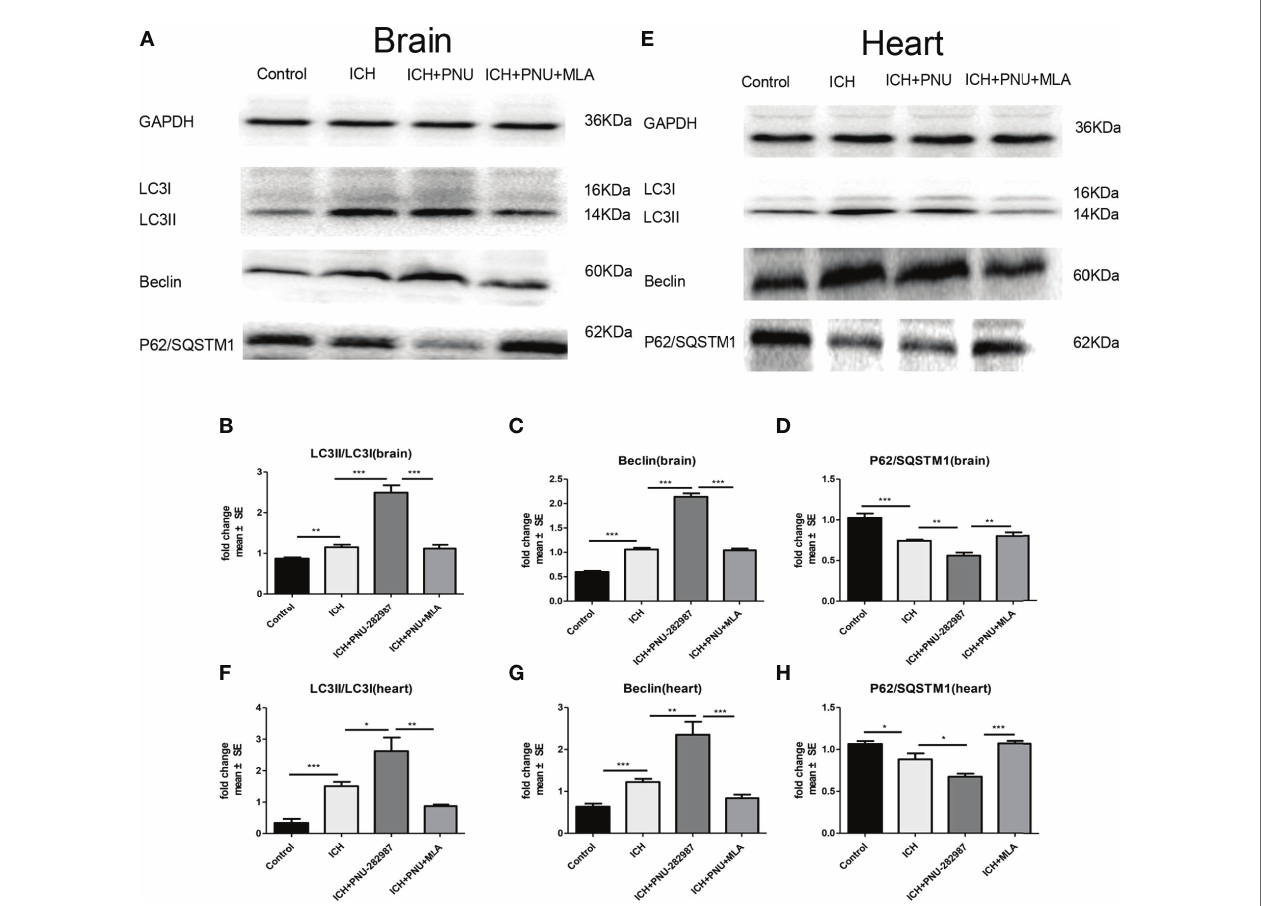
FIGURE 4 | Activating a 7nAChR induced autophagy in the brain and heart of ICH mice. (A) Representative protein expression levels of LC3, Beclin, p62/SQSTM1 in brain evaluated by western blot. (B) Quanti fi cation of western blot data of LC3 in brain. (C) Quanti fi cation of western blot data of Beclin in brain. (D) Quanti fi cation of western blot data of p62/SQSTM1 in brain. (E) Representative protein expression levels of LC3, Beclin, p62/SQSTM1 in heart, as measured by western blot. (F) Quanti fi cation of western blot data of LC3 in heart. (G) Quanti fi cation of western blot data of Beclin in heart. (H) Quanti fi cation of western blot data of p62/ SQSTM1 in heart. n= 6 per group. Data are presented as mean ± SE; *p < 0.05; **P < 0.01; ***P <